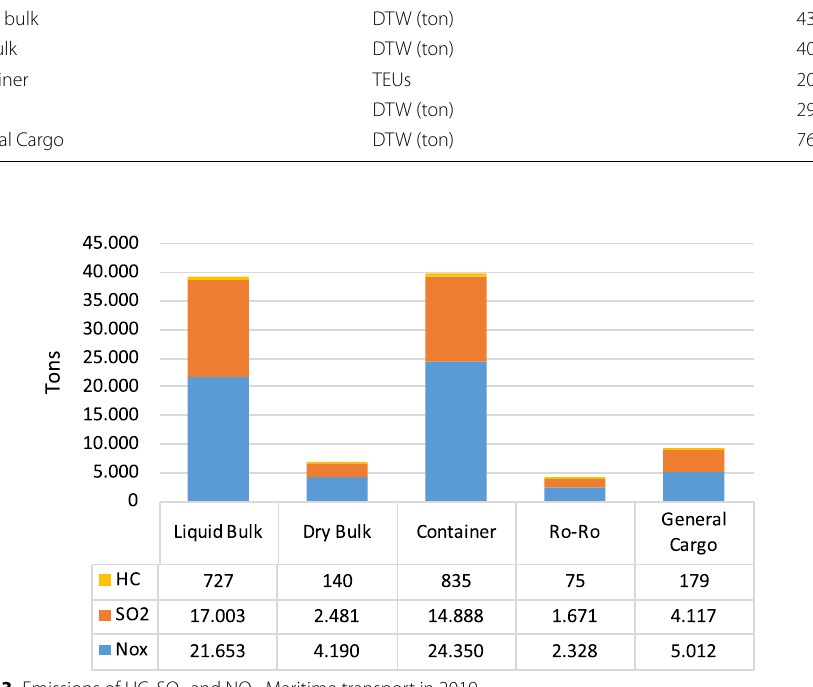
Fig. 3 Emissions of HC, SO 2 and NO x . Maritime transport in